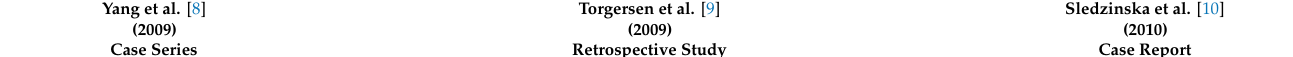
Table 1. Main sepsis-related macroscopic and histologic findings observed post